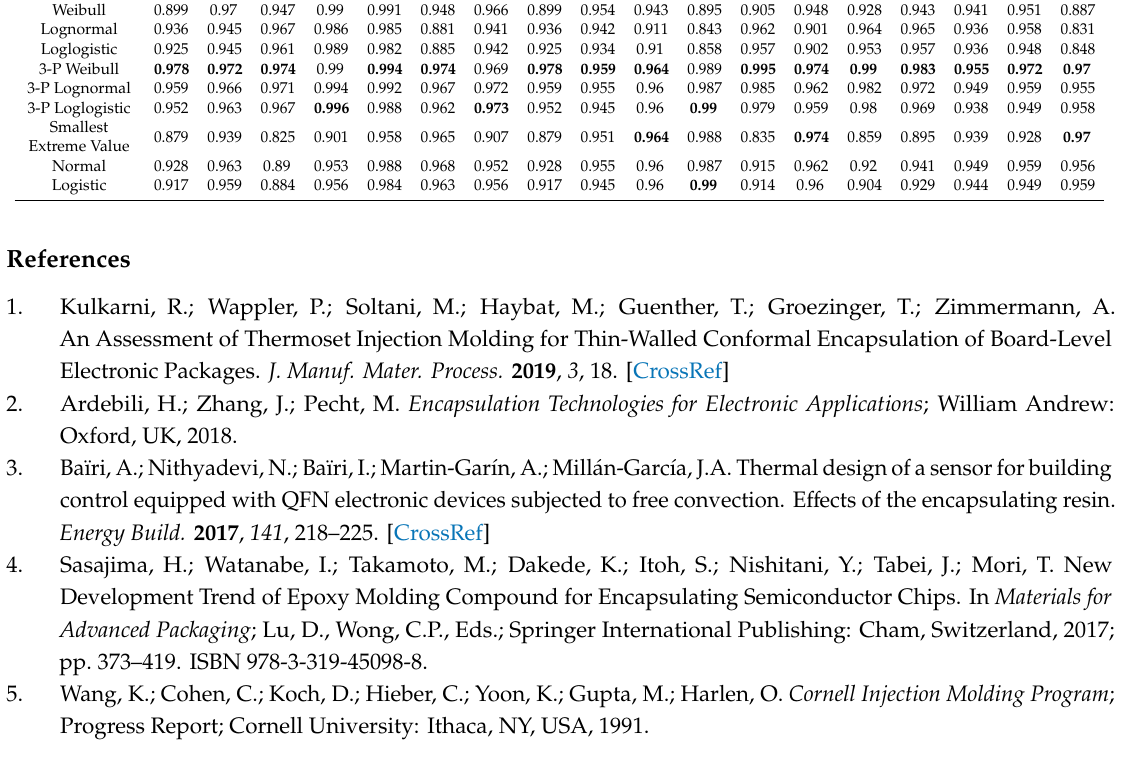
Table A3. Comparison of correlation coe ffi cients for the fitting of the statistical data for all variants.